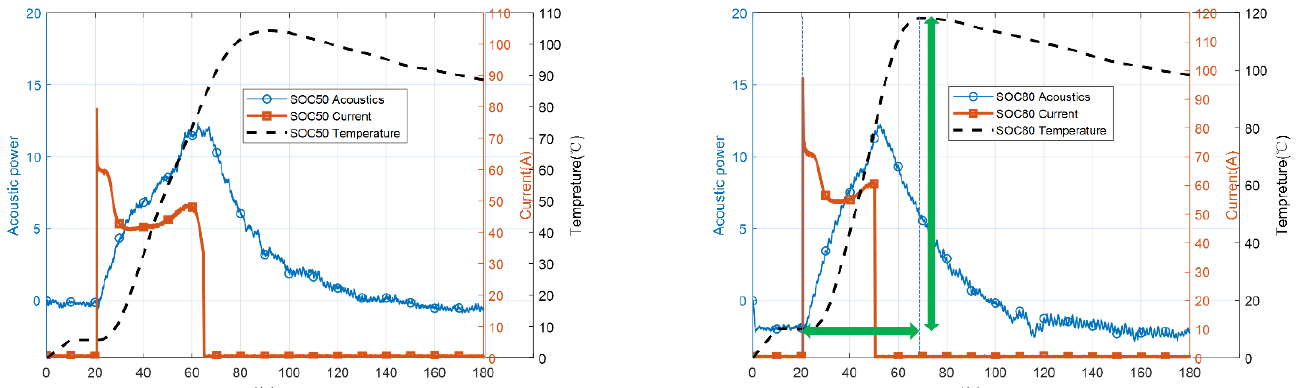
Figure 8. Current, acoustic, and temperature average characteristics of ESC under initial SOC50 and SOC80 conditions.